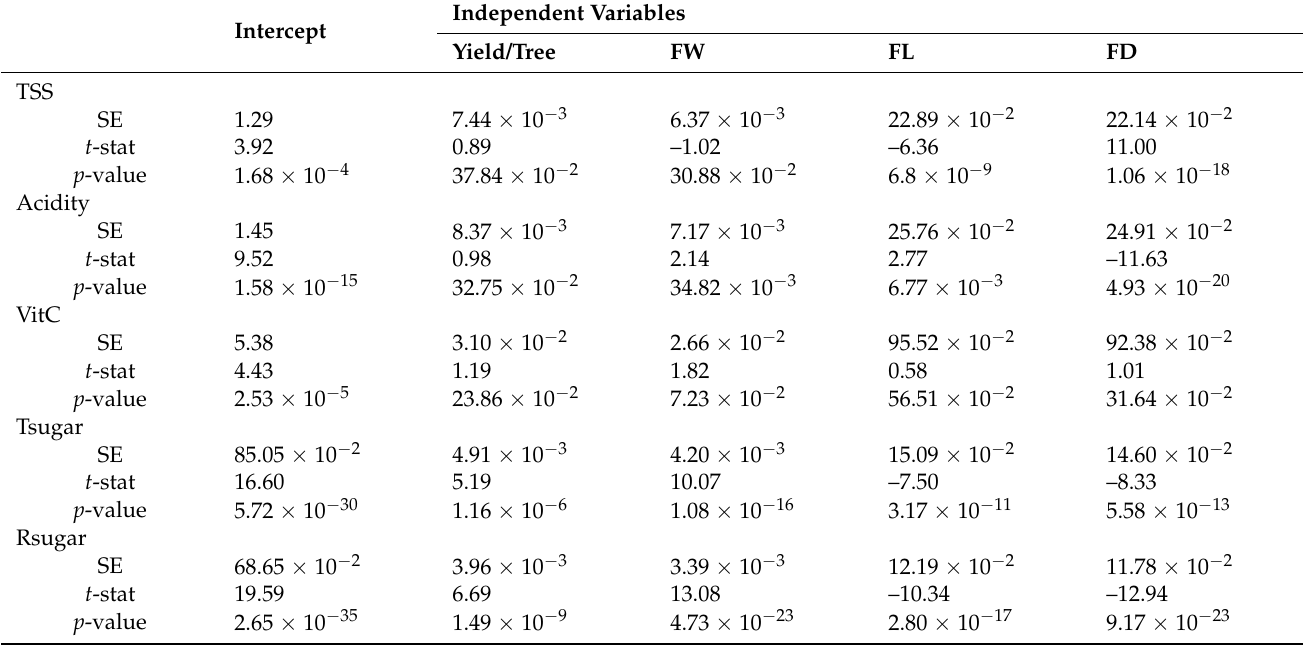
Table 8. Standard error of regression coefficients, t statistic, and probability factor of independent variables for regression